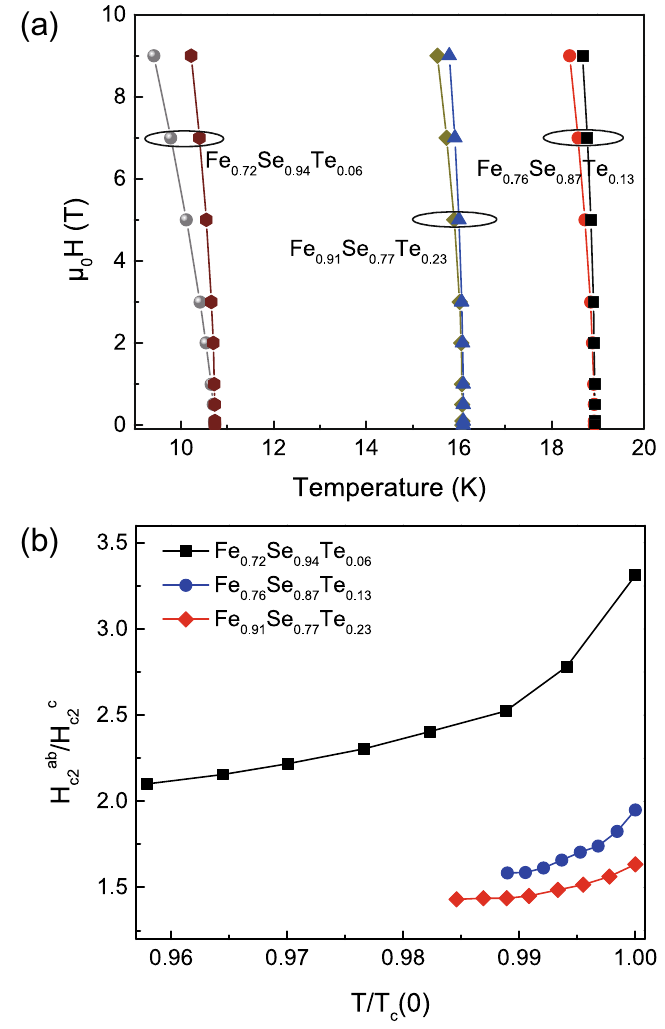
Figure 4. ( a ) Upper critical field versus temperature phase diagram determined by ρ / ρ n = 90%. ( b ) Temperature dependence of anisotropy for Fe 0.72 Se 0.94 Te 0.06 , Fe 0.76 Se 0.87 Te 0.13 and Fe 0.91 Se 0.77 Te 0.23 thin